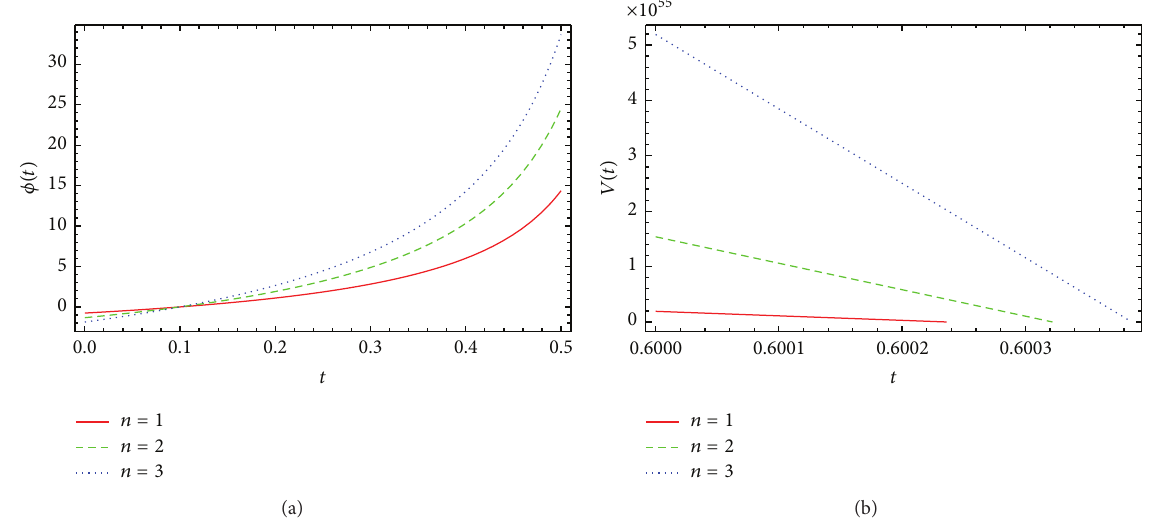
Figure 10: Plots of 𝑓(𝑅,∇𝑅) DBI-essence scalar field (with 𝛾 ̸= constant): (a) 𝜙 versus cosmic time 𝑡 and (b) potential versus 𝑡 (right panel) for 𝑛 = 1 (red), 𝑛 = 2 (green), and 𝑛 = 3